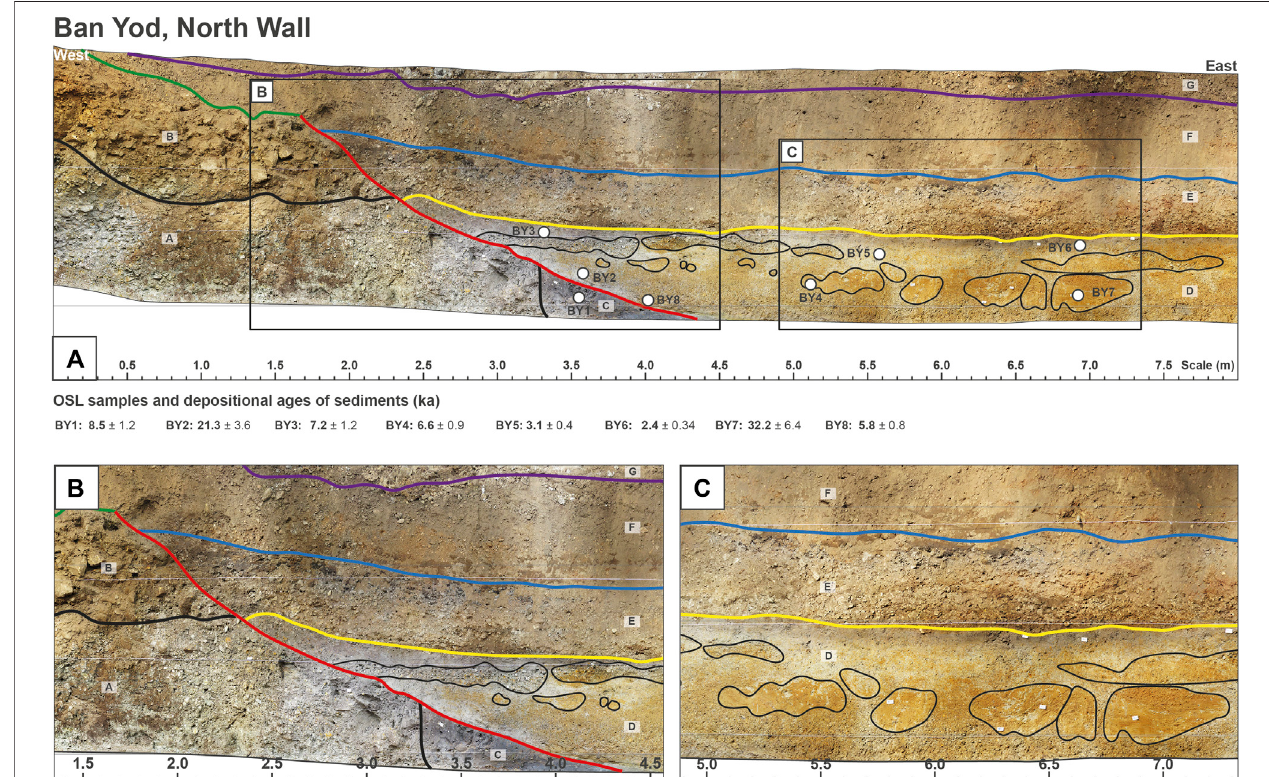
FIGURE 6 | Sections and wall logs for the north wall Ban Yod trench showing sediments, stratigraphy, fault orientation, sample locations for dating, and OSL ages (in ka) of sediment layers. The trench location is shown in Figure 5A . (A) North wall of Ban Yod trench. (B) View showingdiscontinuity of sediment layer and fault traces (red line) were observed on the wall. (C) View showing discontinuity of sediment layer, suggesting possibly a soft-sediment deformation due to earthquake stress.